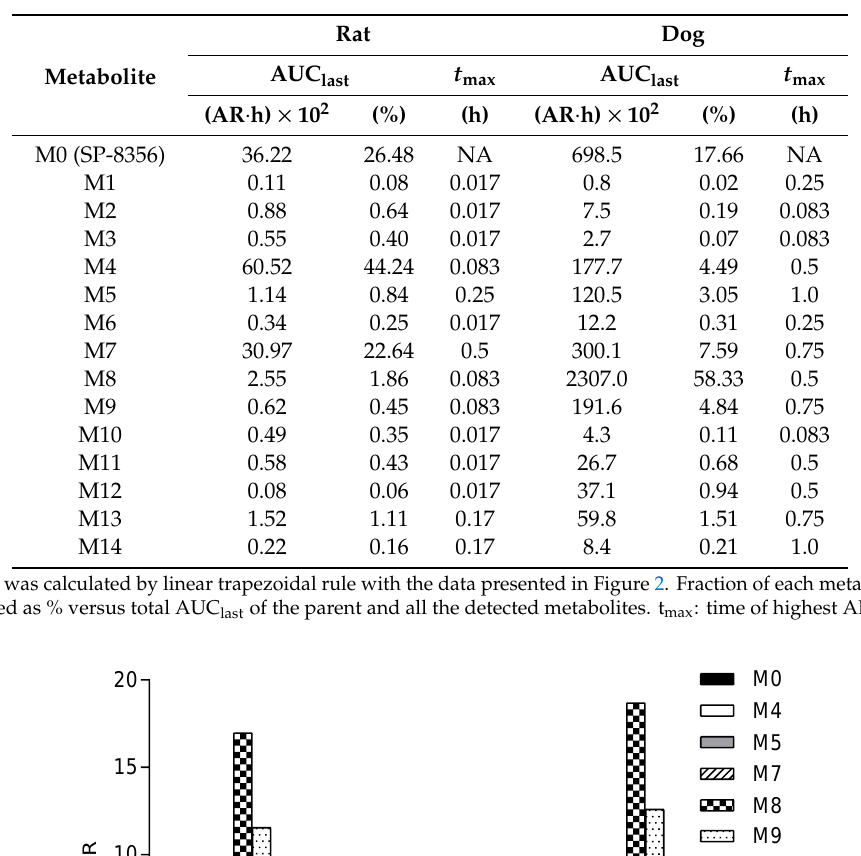
Table 4. Bioactivation of SP-8356 in rat liver S9 fractions. Cofactors